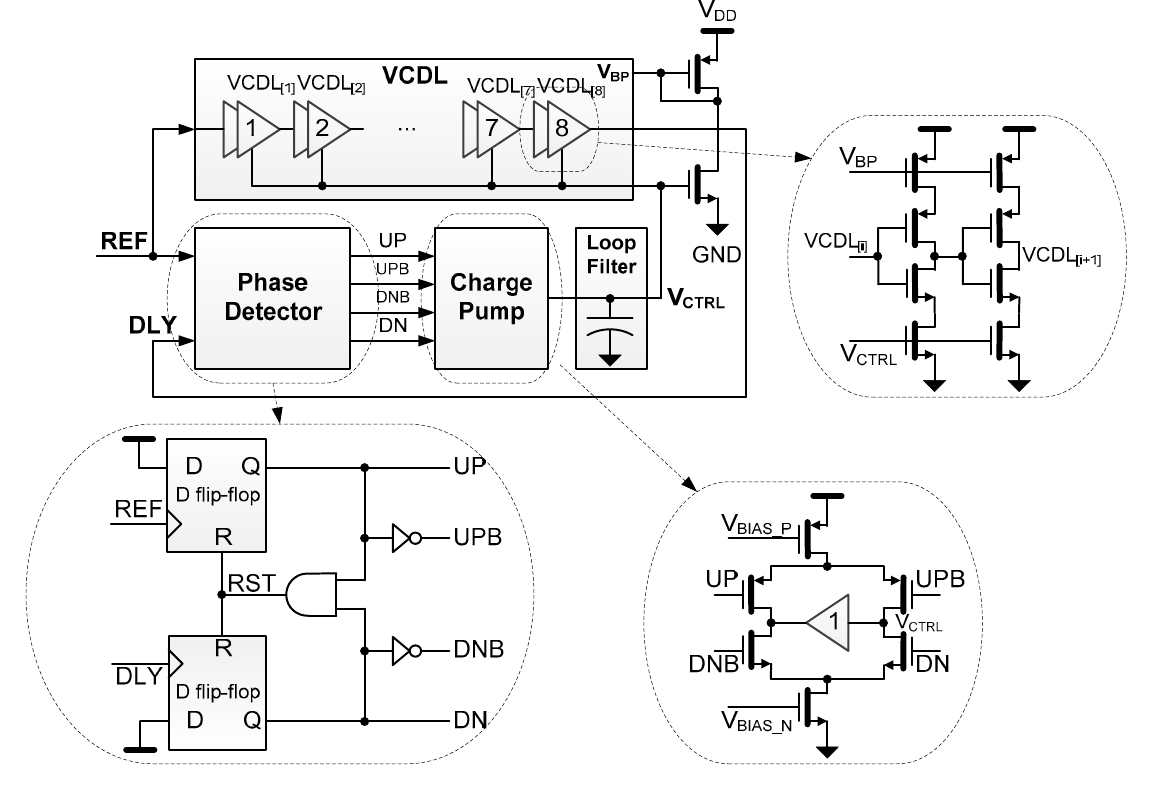
Figure 1. Basic DLL architecture.